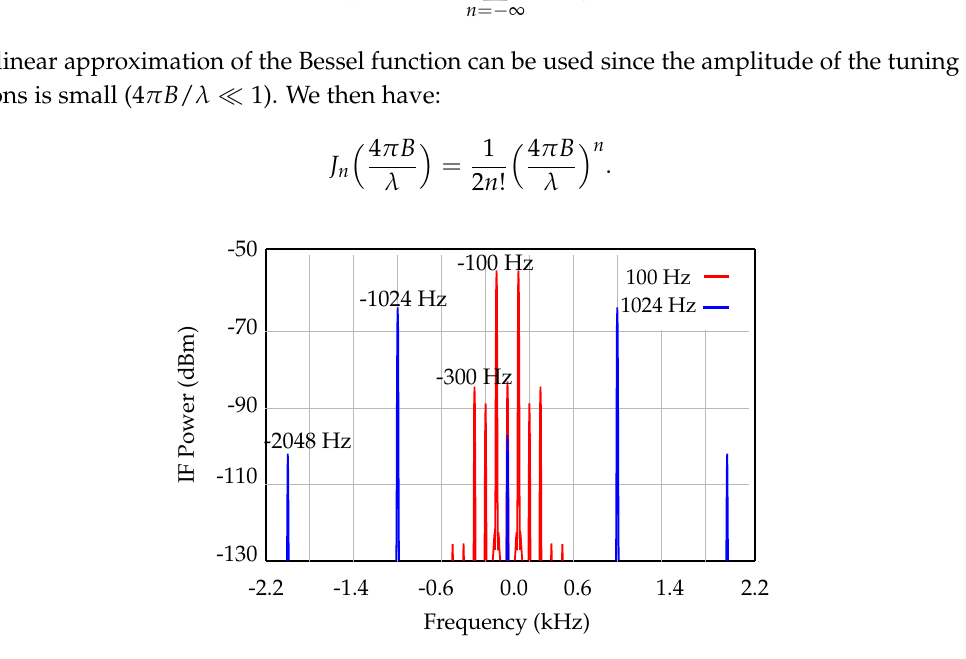
Figure 17. Simulation results for the spectra of the IF signal for the 100-Hz and 1024-Hz tuning forks.